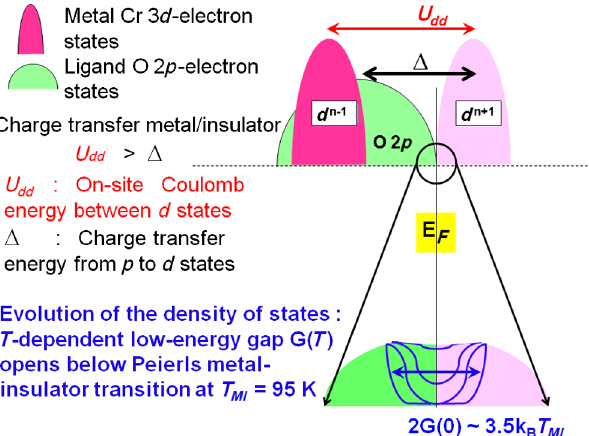
FIG. 6. Schematic electronic structure of K 2 Cr 8 O 16 . K 2 Cr 8 O 16 exhibits a charge-transfer-type half-metallic ground state with U > Δ in the high- T ferromagnetic metal phase, as shown in the top panel. On reducing T , it undergoes a Peierls metal-insulator ¼ 95 K, with a gradual depletion of spectral transition below T MI weight at and near E , consistent with a second-order BCS-like F temperature-dependent gap (lower